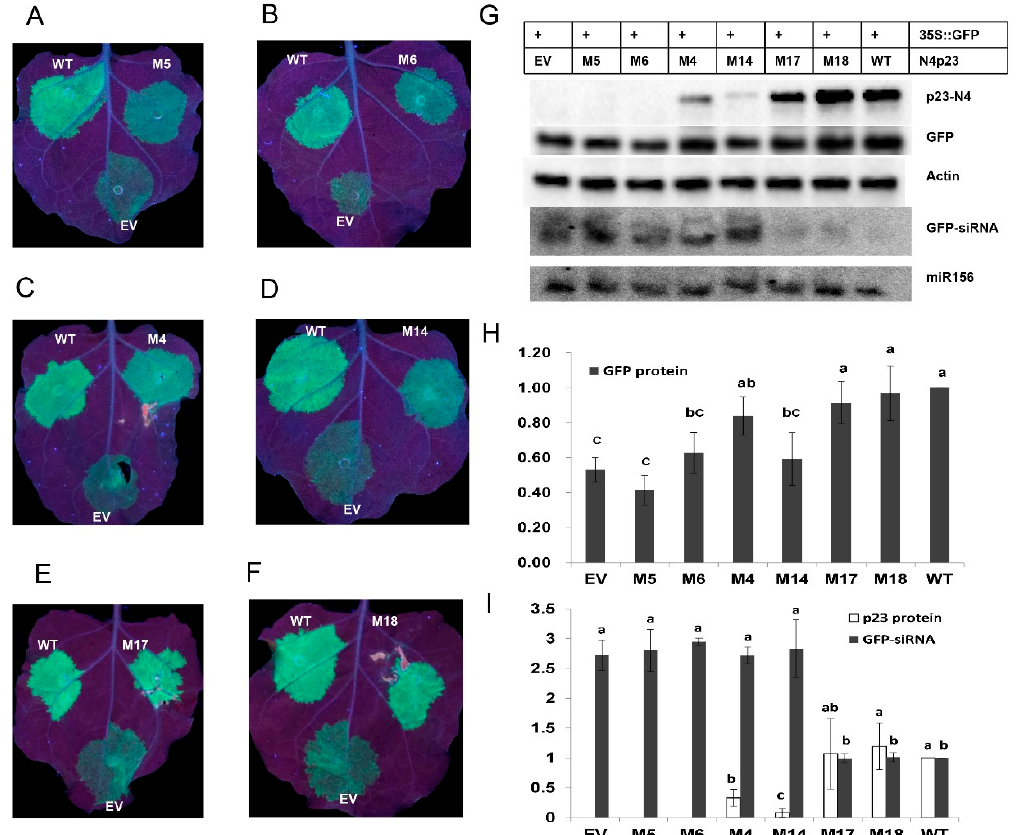
Figure 5. Characterization of p23 mutants in transient assays. ( A – F ) 35S-GFP was co-infiltrated with wild-type p23 (WT), negative control (EV), and indicated p23 mutant in three patches. Representative leaves were photographed under UV light at 5 days after infiltration (DAI). ( G ) Western and Northern blot analysis of co-infiltration samples. Top two rows indicate combination of co-expressed genes. Proteins (N4p23, GFP, and Actin) detected by Western blot are indicated to the left of each blot. Small RNAs (GFP and miR156 siRNA) detected by Northern blot are also indicated to the left of each blot. ( H ) Histogram of normalized expression value of GFP protein quantified from three independent experiments. ( I ) Histogram of normalized expression value of N4p23 protein and GFP siRNA quantified from western blots and northern blots in G. Columns with di ff erent letters indicate significant di ff erences according to Duncan’s multiple tests ( p < 0.05). Western blots and northern blots performed 3 and 2 independent experiments,